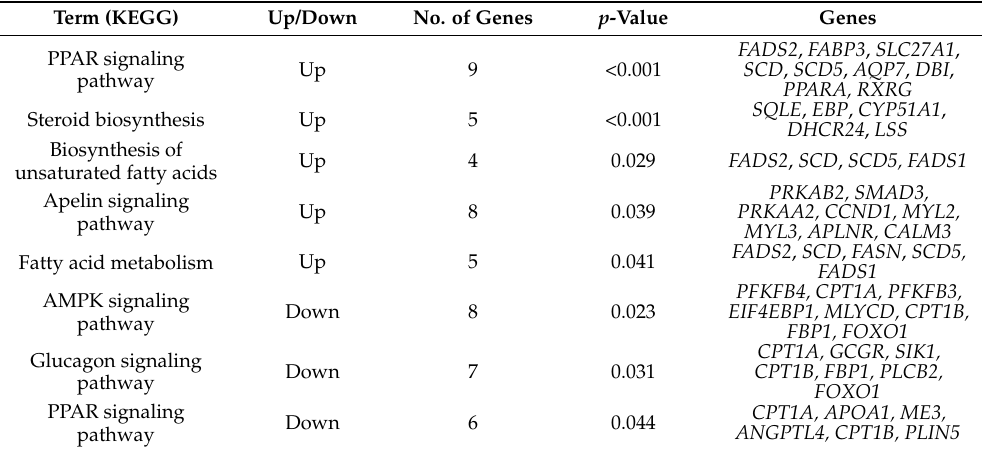
Table 6. Enriched metabolic pathways ( p < 0.05) highlighted in over-representation analysis of up- and down-regulated differentially expressed genes identified in G2 at weaning.